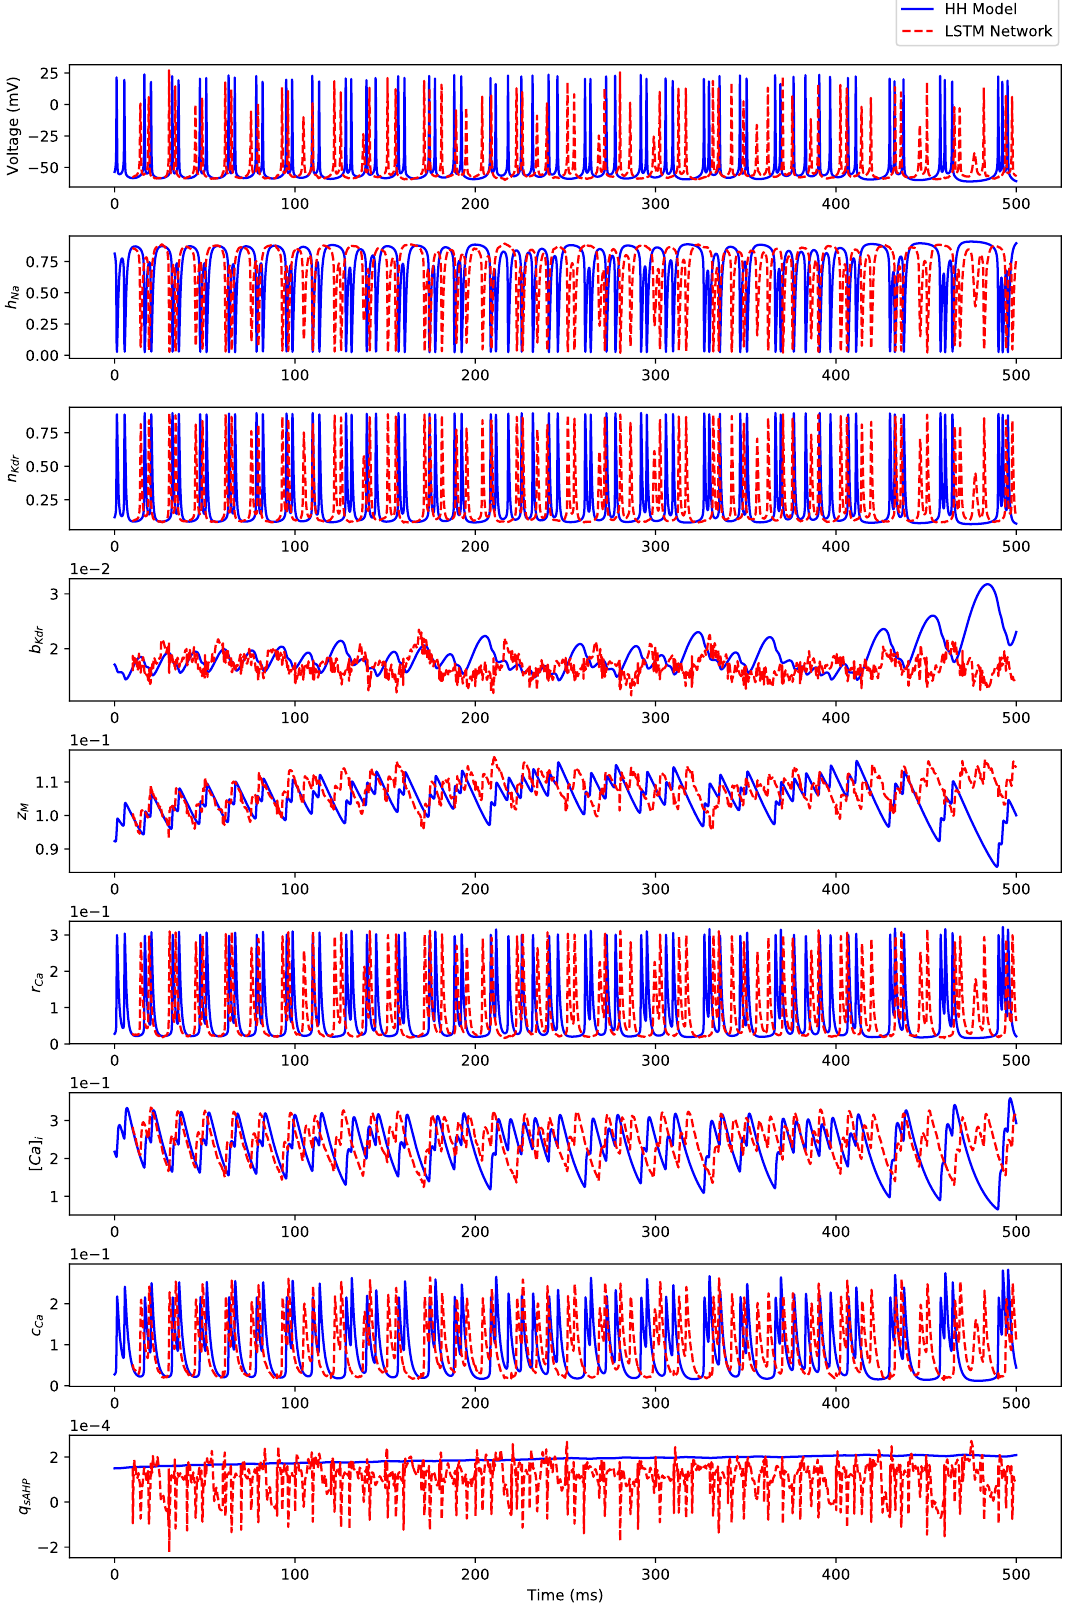
Figure A8. Comparison between the Hodgkin-Huxley model (“HH Model”) states’ dynamics and the iterative predictions of states’ dynamics using the 100 timesteps predictive horizon-based deep LSTM neural network (“LSTM Network”) in response to I = 1.5